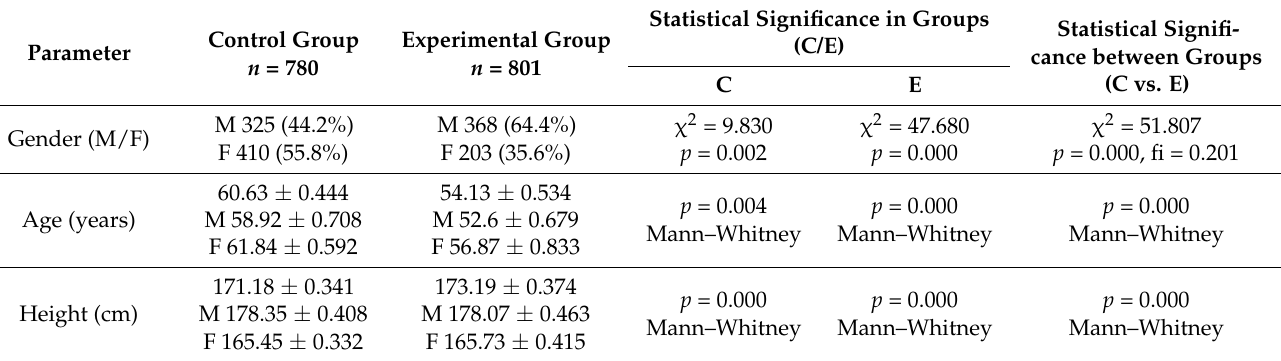
Table 1. Demographic characteristics of study population. Results are presented as mean ± standard means of errors (X ± SEM) in control and experimental groups. Statistical difference was confirmed by chi-squared and Mann–Whitney U